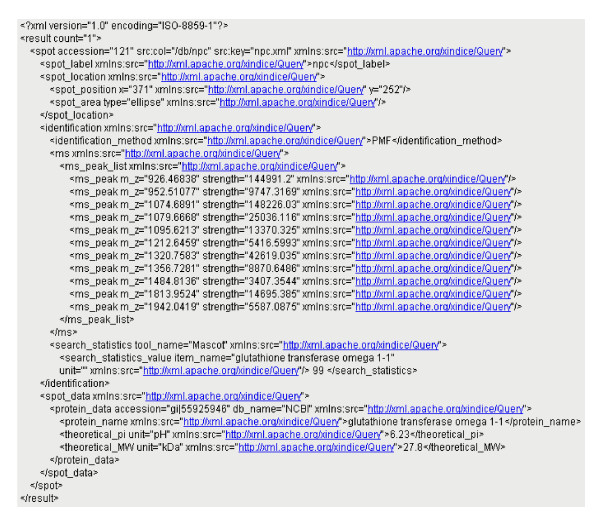
Example of Spot Section processed by Internet Explore. One NPC 2D/MS repository query result displayed in Internet Explore without transforming with Sablotron XSLT processor. The root of the query result XML document was result tag. Every query record would be inserted among spot tag.